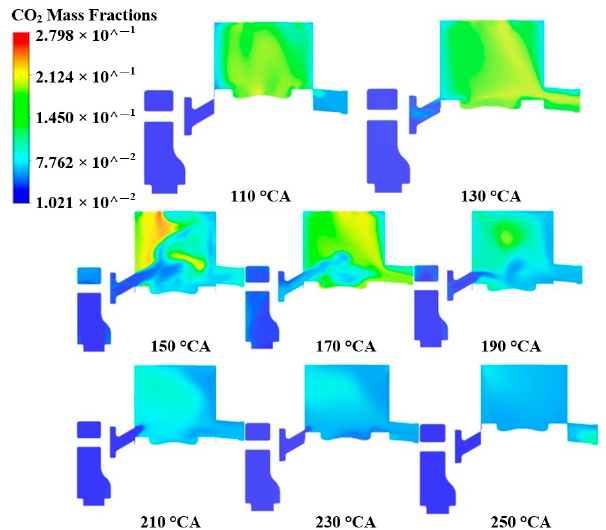
Figure 14. Variation of CO 2 Distribution on Cylinder Meridional Surface during Cross Scavenging.